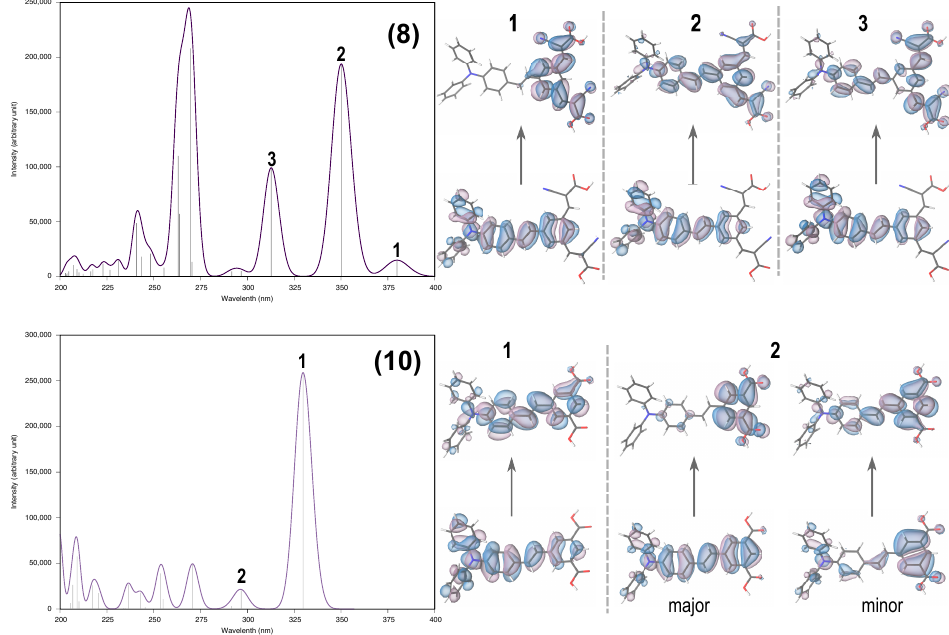
Figure 3. In the left panel are the simulated spectra of dyes ( 8 ) and ( 10 ) generated by the orca_mapspc utility program. In the right panel are the natural transition orbitals associated with the electronic transitions around and beyond 300 nm as marked on the spectra; the vertical arrows indicate a transition from an occupied orbital to an unoccupied orbital. The orbitals are plotted with an isosurface value of 0.02